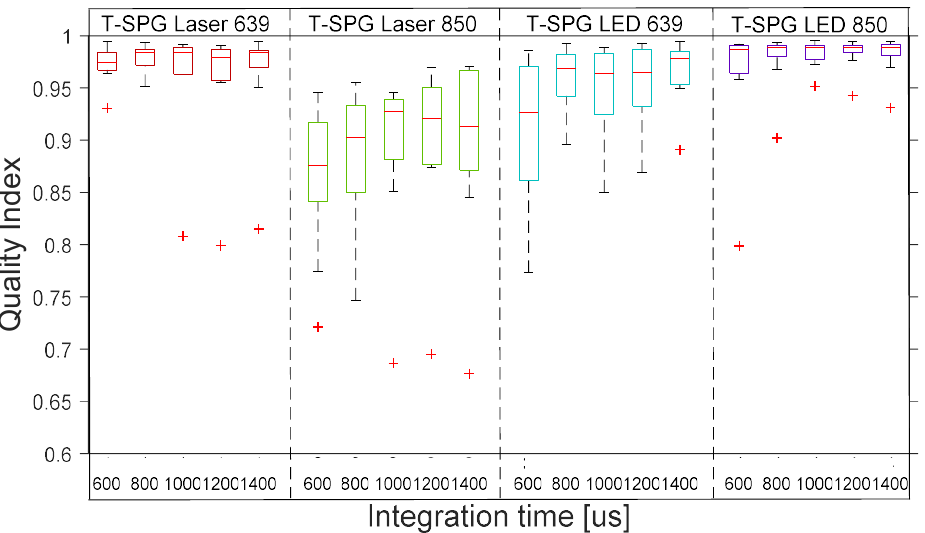
Figure 10. Boxplots of quality index of rSPG signals with 4 different lights at 5 integration times in transmission. Note the higher signal quality of 850 nm “SPG” signal when using LEDs instead of lasers. The inner box divisions indicate: Q1 (the first quartile) to Q3 (the third quartile). The median is marked by a line across the box. The “whiskers” indicate results from Q1 and Q3 to the most extreme data points. The + symbols represent outliers.